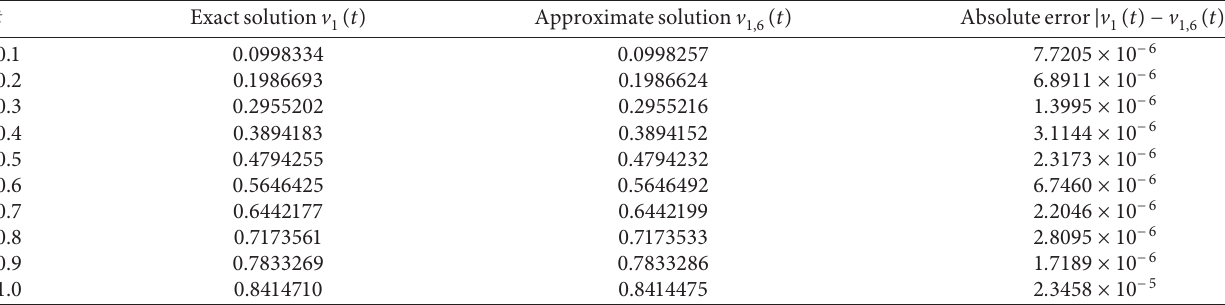
( t ) and approximate v ( t ) solutions for Example 2 at β � 1 and k � 6 over the interval [0, 1]. 1 1 , 6